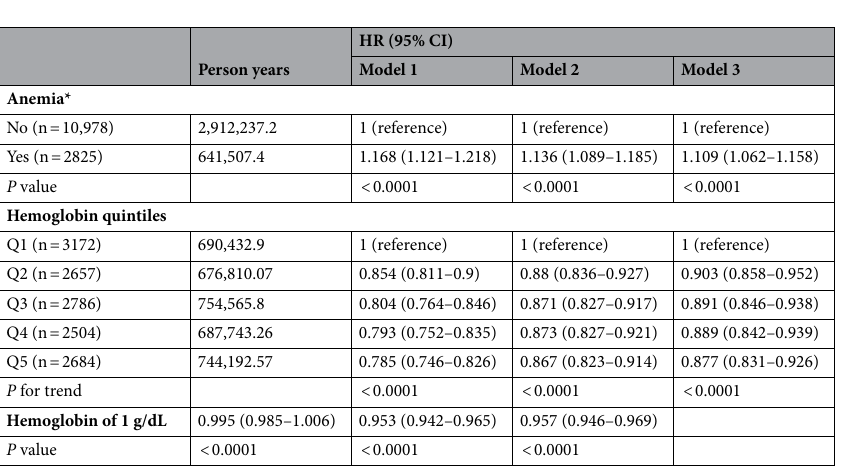
Table 2. Hazard ratios for psoriasis according to the presence and severity of anemia among patients with chronic kidney disease. Model 1 was not adjusted for any variable. Model 2 was adjusted for age and sex. Model 3 was adjusted for age, sex, body mass index, smoking status, alcohol consumption, physical activity, income, glomerular filtration rate, diabetes, hypertension, and dyslipidemia. *Anemia was defined as a hemoglobin level of < 13 g/dL in men and < 12 g/dL in